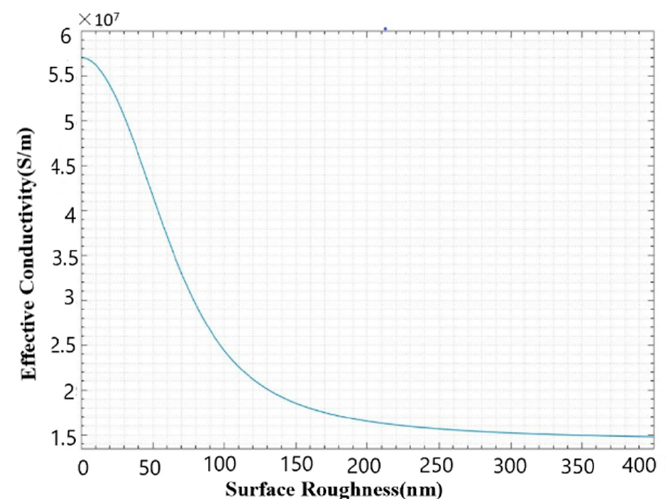
Figure 13. The effect of surface roughness on effective conductivity values at 340 GHz, showing the relative decrease in conductivity as a function of surface roughness.